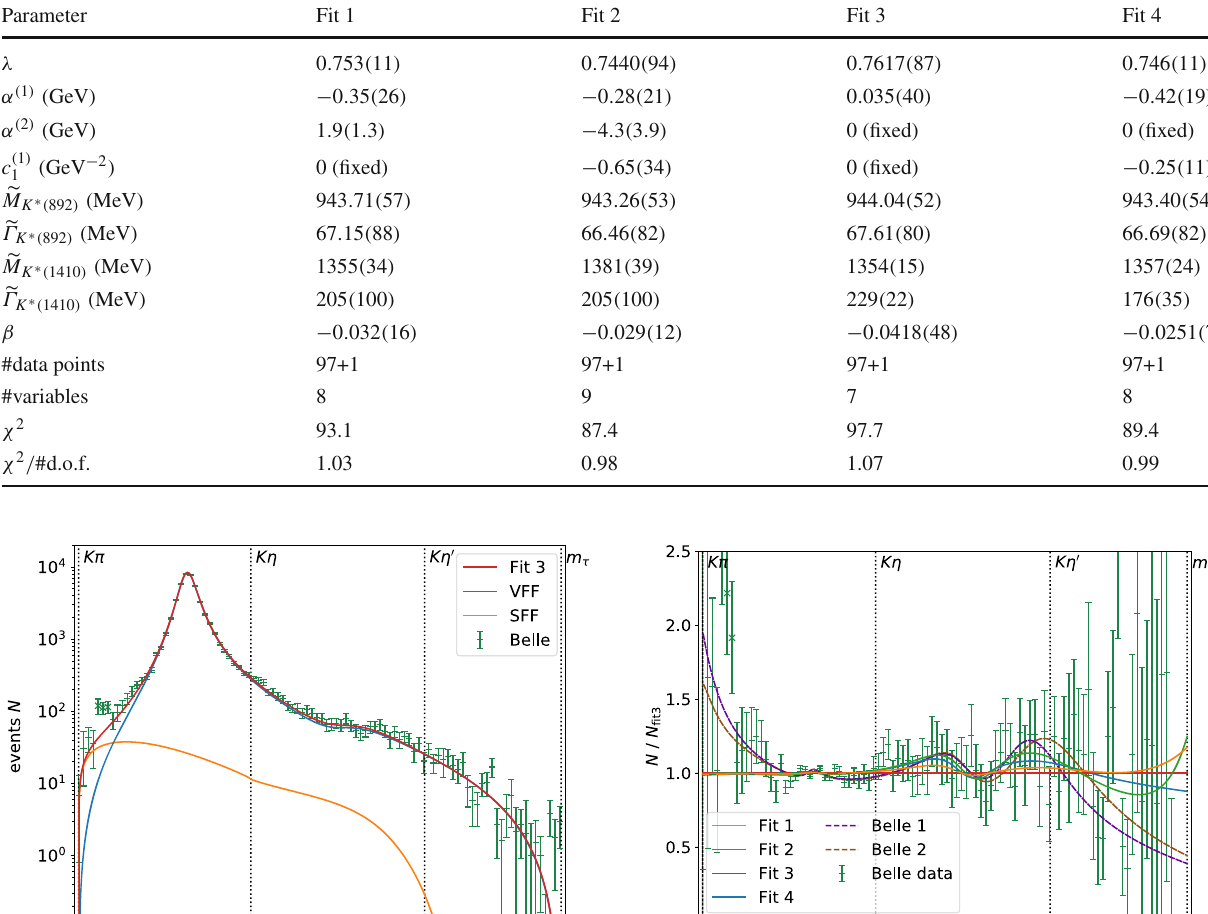
with different combinations of fixed α ( 2 ) and c outcome of all fits is quite close, only Fit 3 is shown exemplarily in Fig. 4, while we display the comparison between the fits in Fig. 5